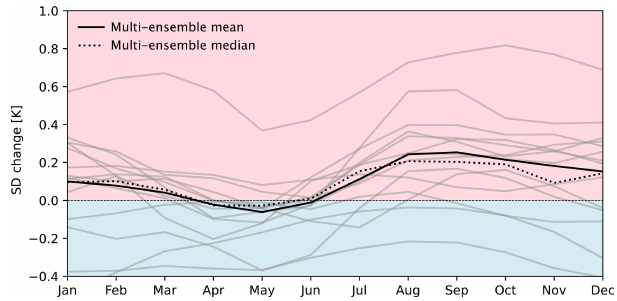
Figure 5. Change in ENSO SST variability taken as the ensemble standard deviation in the Niño3.4 region for the period 2070–2099 as compared to 1951–1980. The grey lines are individual large en- sembles, while the black line is the multi-ensemble mean and the black dashed line is the multi-ensemble median. Red shading indi- cates an increase in this metric, while blue indicates a